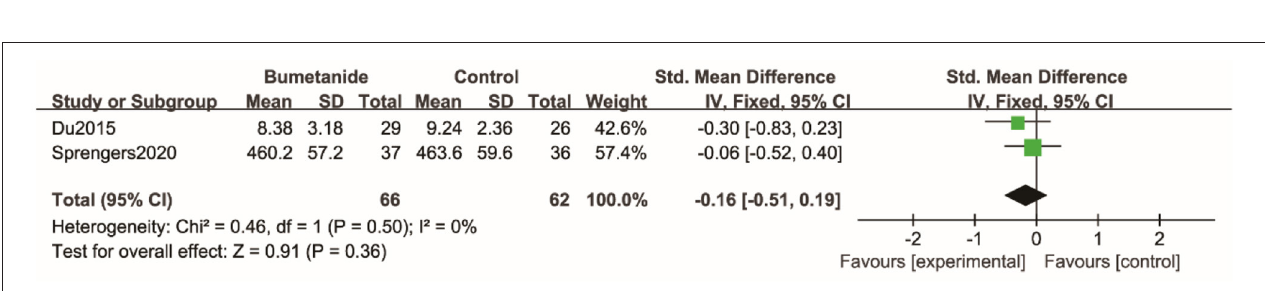
FIGURE 8 | Forest plot of the efficacy of bumetanide on Sensory in children with ASD.